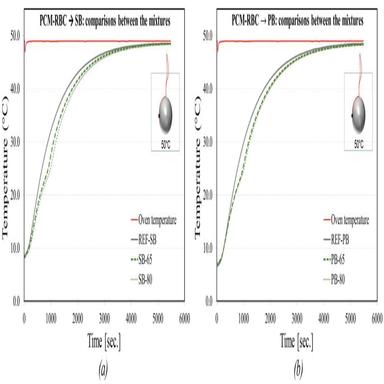
Experimental temperature evolutions and comparisons: (a) PCM-RBA mortars with SB bricks; (b) PCM-RBA mortars with PB bricks. Results represent the average of three measurements.